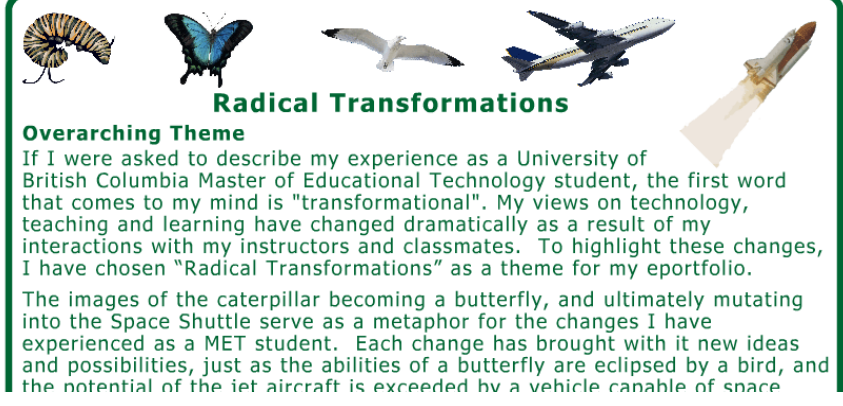
DK had undergone a similar transformation moving from an administrative and managerial job towards teaching. She saw her learning experience as a time-line of continual growth. DK did not use images to represent this process, but she successfully implemented a colour